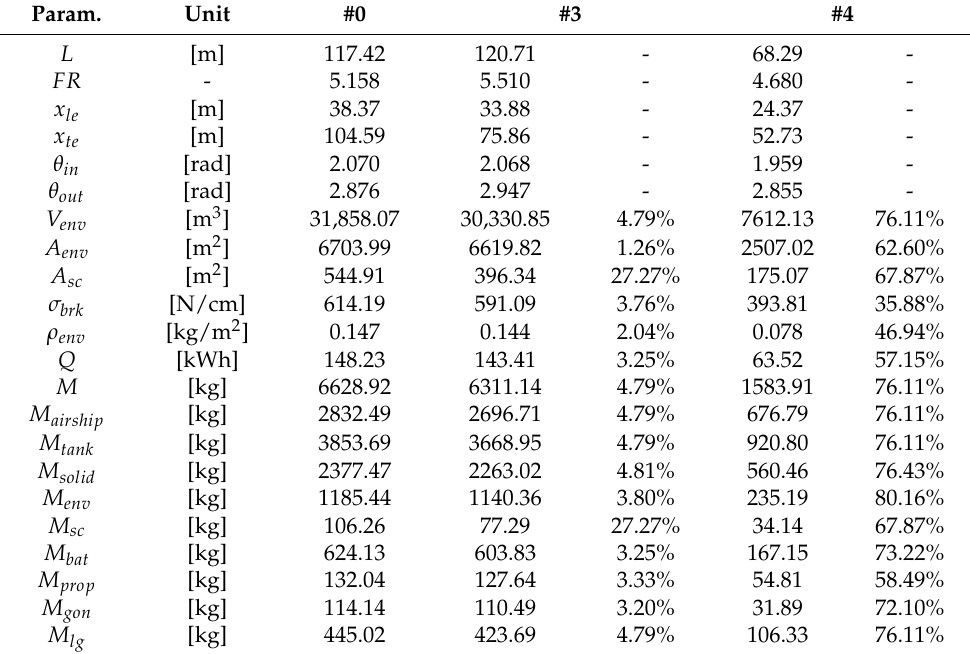
Table 13. Effect of technological advancements and design improvements on optimal design for operation at 20 km altitude above L’Aquila, Italy (Part 2). For each case, the first column gives the absolute value of the parameter, while the second column gives the percent reduction compared to the baseline #0.